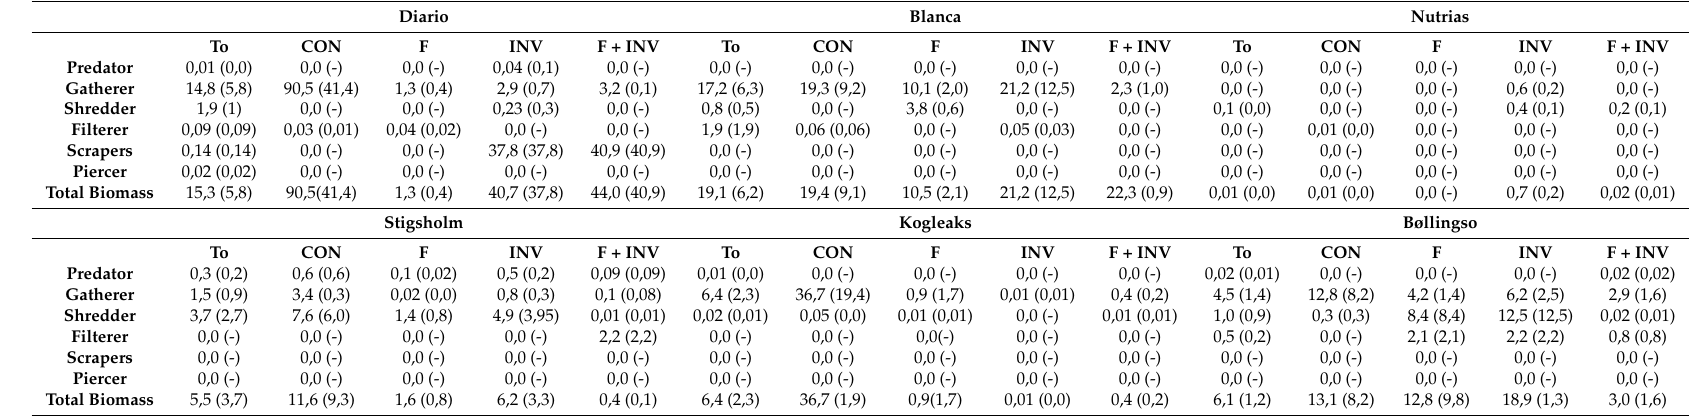
Table 3. Trophic group biomass (mg g − 1 plant) of plant-attached invertebrates at the start (To) and at the end of the experiment. (CON (Control); F (fish); F + INV (fish + predatory macroinvertebrates) and INV (predatory macroinvertebrates). Upper panel shows the subtropical Uruguayan lakes (30–35 ◦ S) and the lower panel the temperate Danish lakes (55–57 ◦ N). Standard errors are in